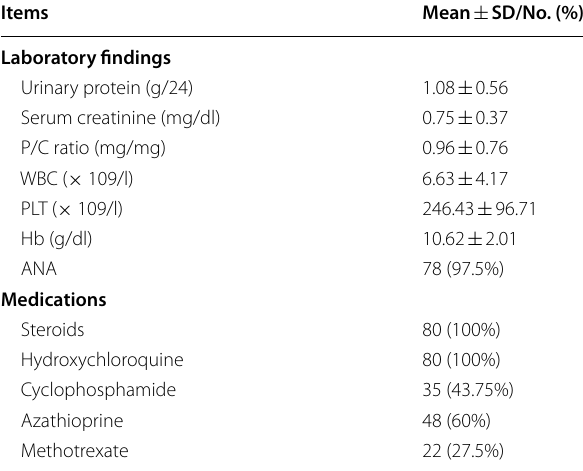
Table 2 Laboratory findings and medications of SLE